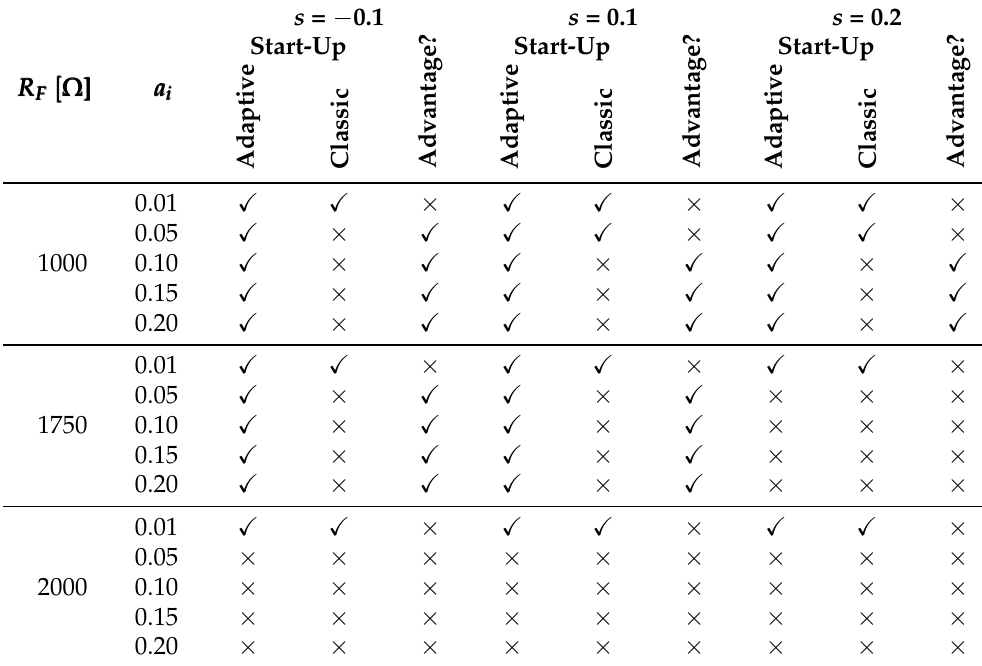
Table 8. Effectiveness of the zero-sequence current adaptive criterion in networks with different values of the earth fault detuning coefficient s